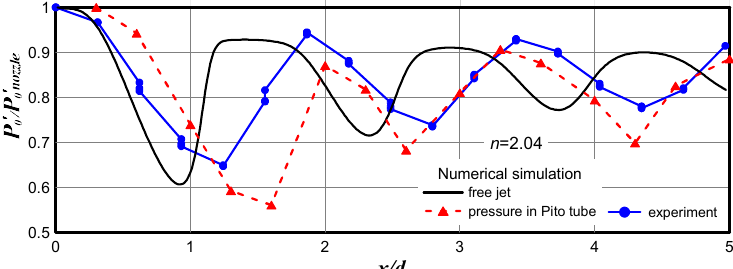
Figure 4. Comparison of the experimental and predicted data for a real microjet escaping from the nozzle 16.1 µm in diameter at n = 2.04.